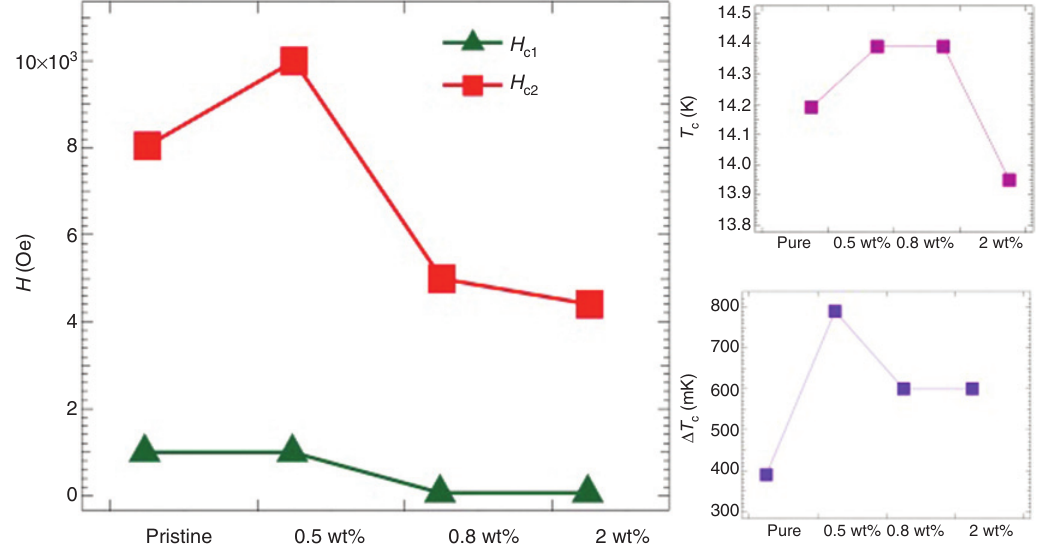
and H (obtained from magnetism measurements) and T c 1 c 2